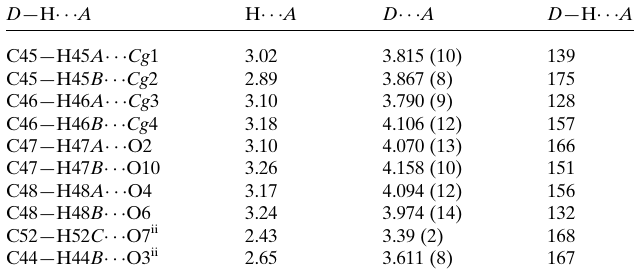
Table 2 Summary of weak interactions (C—H (cid:2)(cid:2)(cid:2) (cid:2) and C—H (cid:2)(cid:2)(cid:2) O; A˚ , (cid:5) ) between the pillararene and 1-octanamine molecules. Cg 1, Cg 2, Cg 3 and Cg 4 are the centroids of the C1–C6, C29–C34, C15–C20 and C22–C27 rings, respectively.